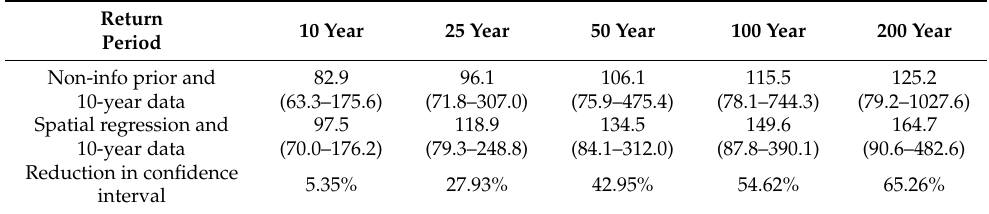
Table 7. Estimation of the discharge (m 3 /s) for certain design floods with 95% confidence